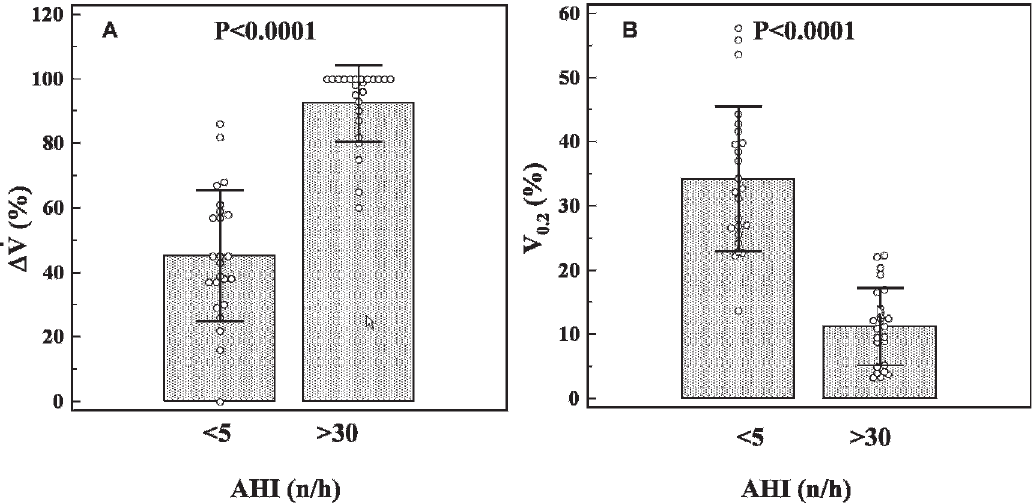
Figure 3 - Comparison of the (A) flow drop percent of the peak flow D _ VV (%) and (B) the expiratory volume at 0.2 s [the percent of the mean inspiratory volume V 0.2 (%)] between normal and severe OSA